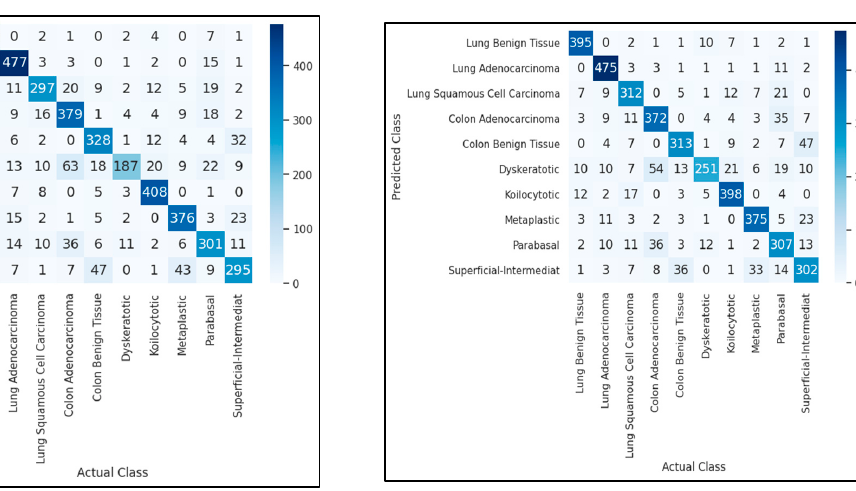
( d ) Communication rounds—250 Figure 8. FedProx—confusion matrix. In order to visualize the difference between the performance of FedAvg and FedProx, we projected and showed the accuracy and loss of both algorithms in Figures 9 and 10.